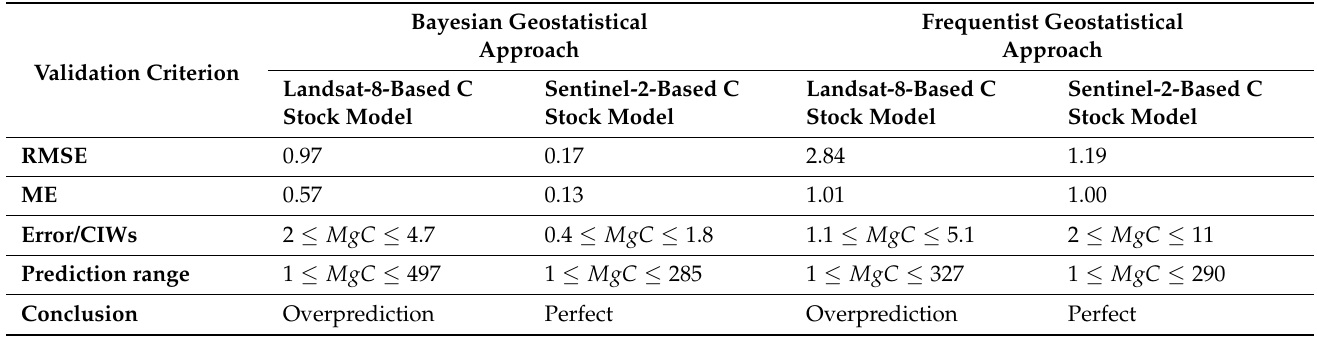
Table 7. Summaries of the Bayesian and the frequentist geostatistical approaches. CIWs = Confidence Interval Widths; ME = Mean Error; RMSE = Root Mean Square